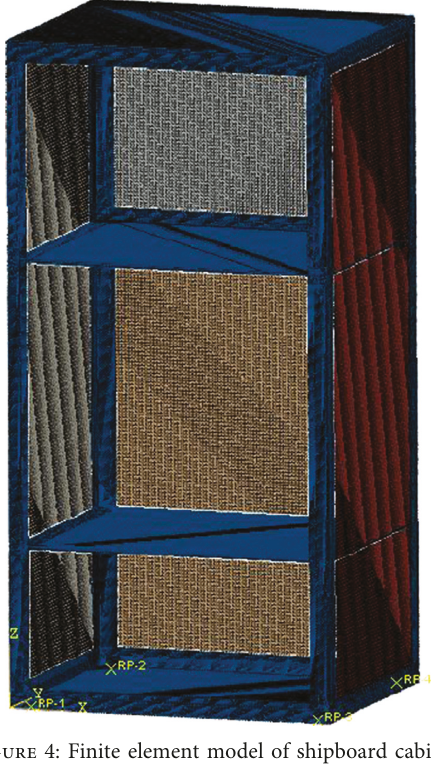
Figure 4: Finite element model of shipboard cabinet.